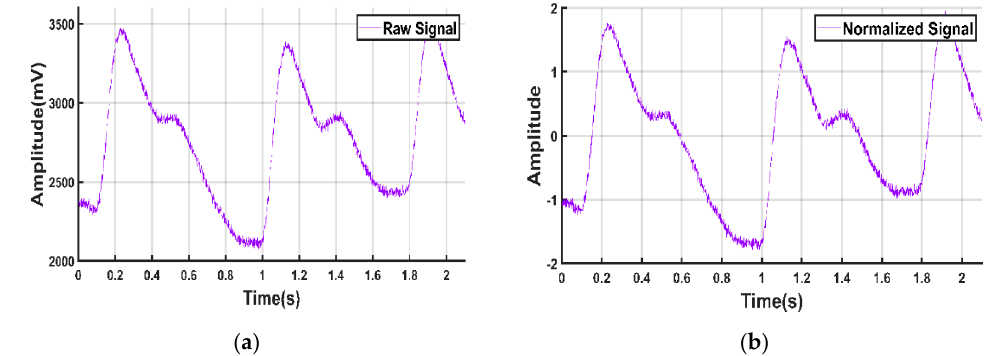
Figure 4. PPG signal. ( a ) Before normalization; ( b ) after normalization.